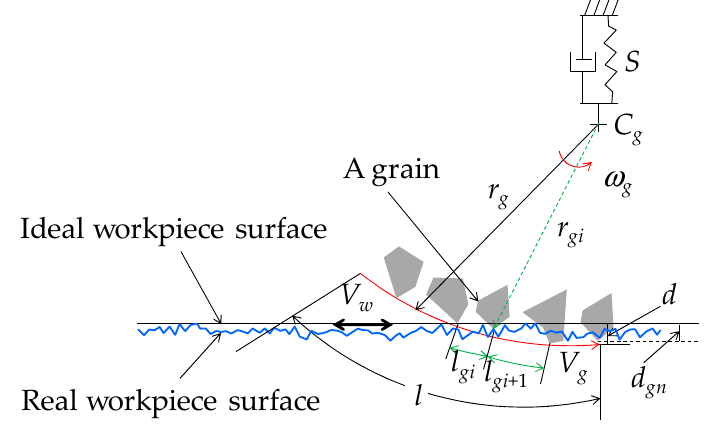
Figure 5. Microscopic interaction between abrasive grain and workpiece.